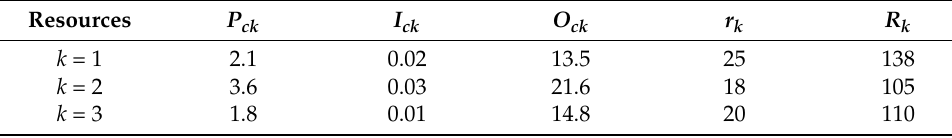
Table 3. Details on other parameters.